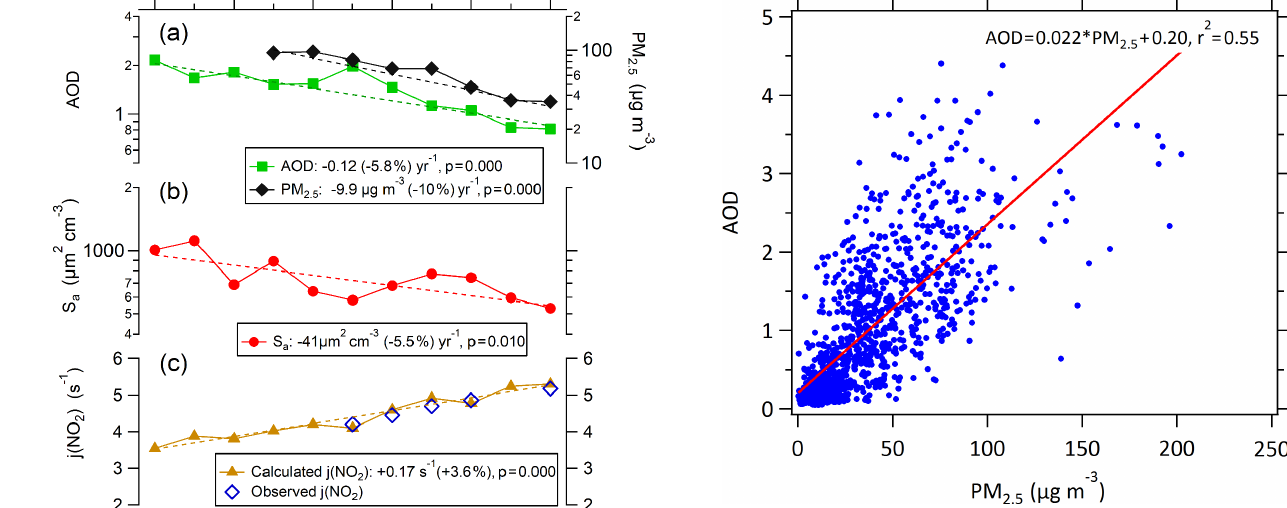
AOD and PM 2 . 5 are linearly correlated with a correlation coefficient of + 0 . 74. This result indicates that the decrease in PM 2 . 5 was the primary cause of the reduction in AOD.